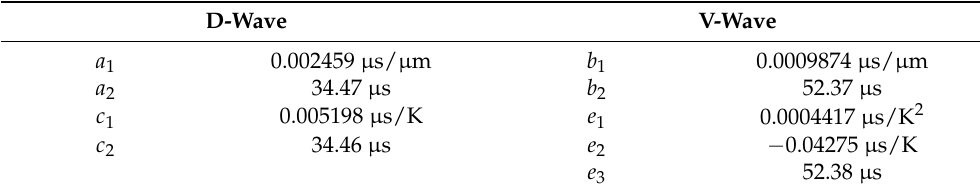
Table 1. Fitting parameters for the calibration curves of the D- and V-wave.